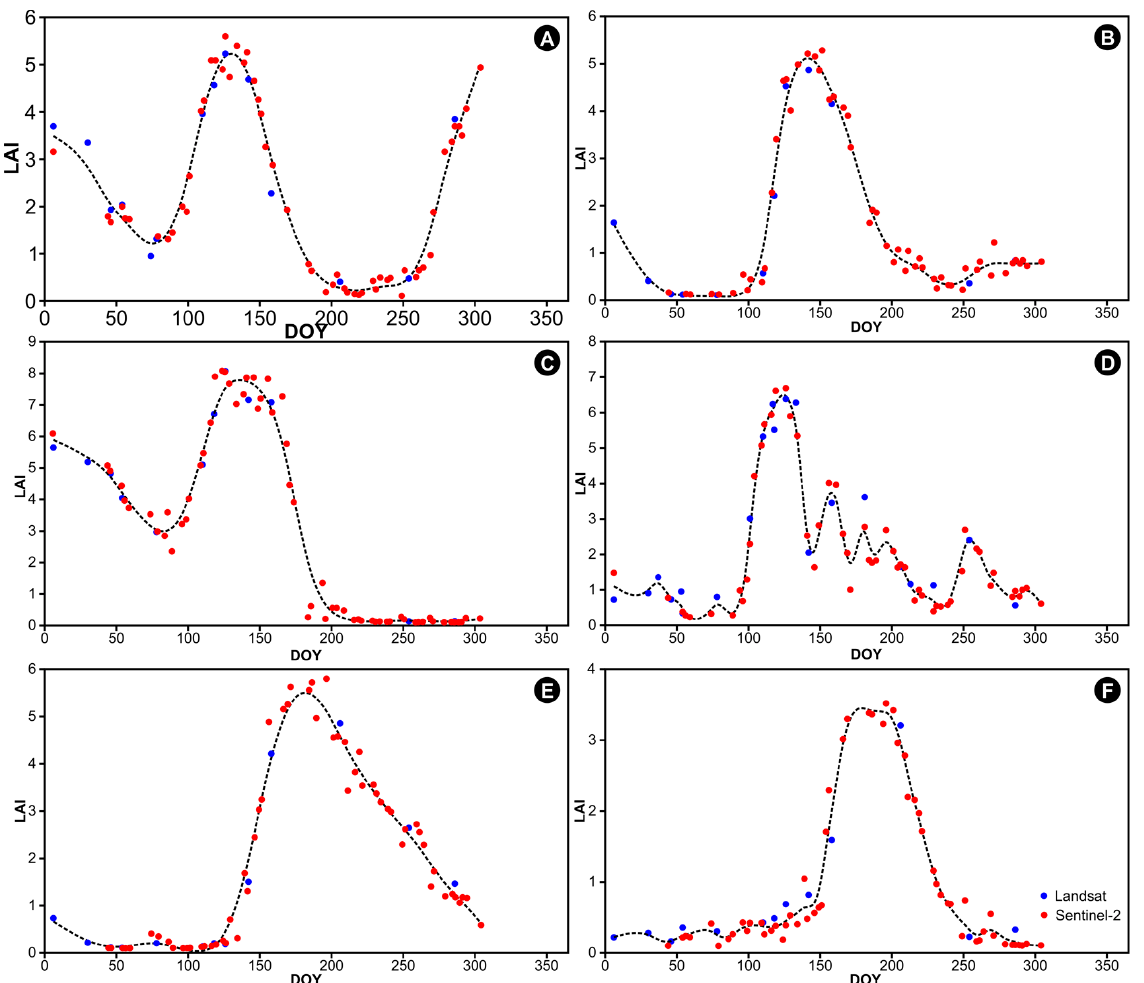
Figure 5. Example of harmonized LAI time series from Sentinel-2 MSI and Landsat OLI data acquired during 2018 for winter wheat ( A ); spring barley ( B ); winter rapeseed ( C ); alfalfa ( D ); sugar beetroot ( E ); and corn ( F ).